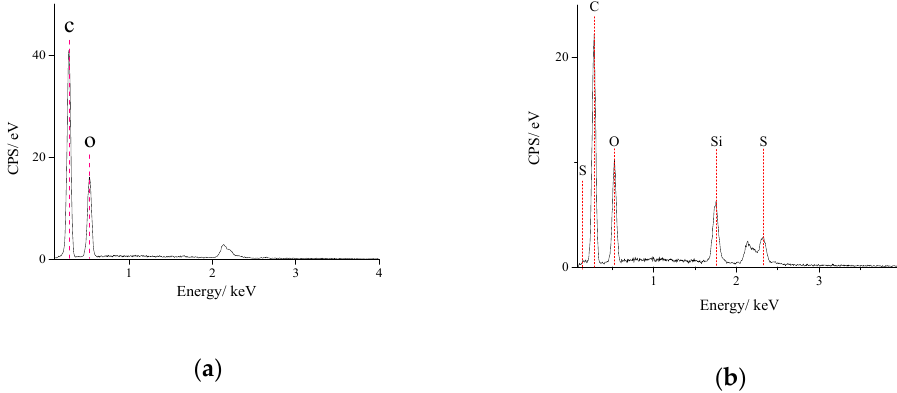
Figure 13. EDX analysis chart of GOs ( a ) and GOs-SH ( b ).